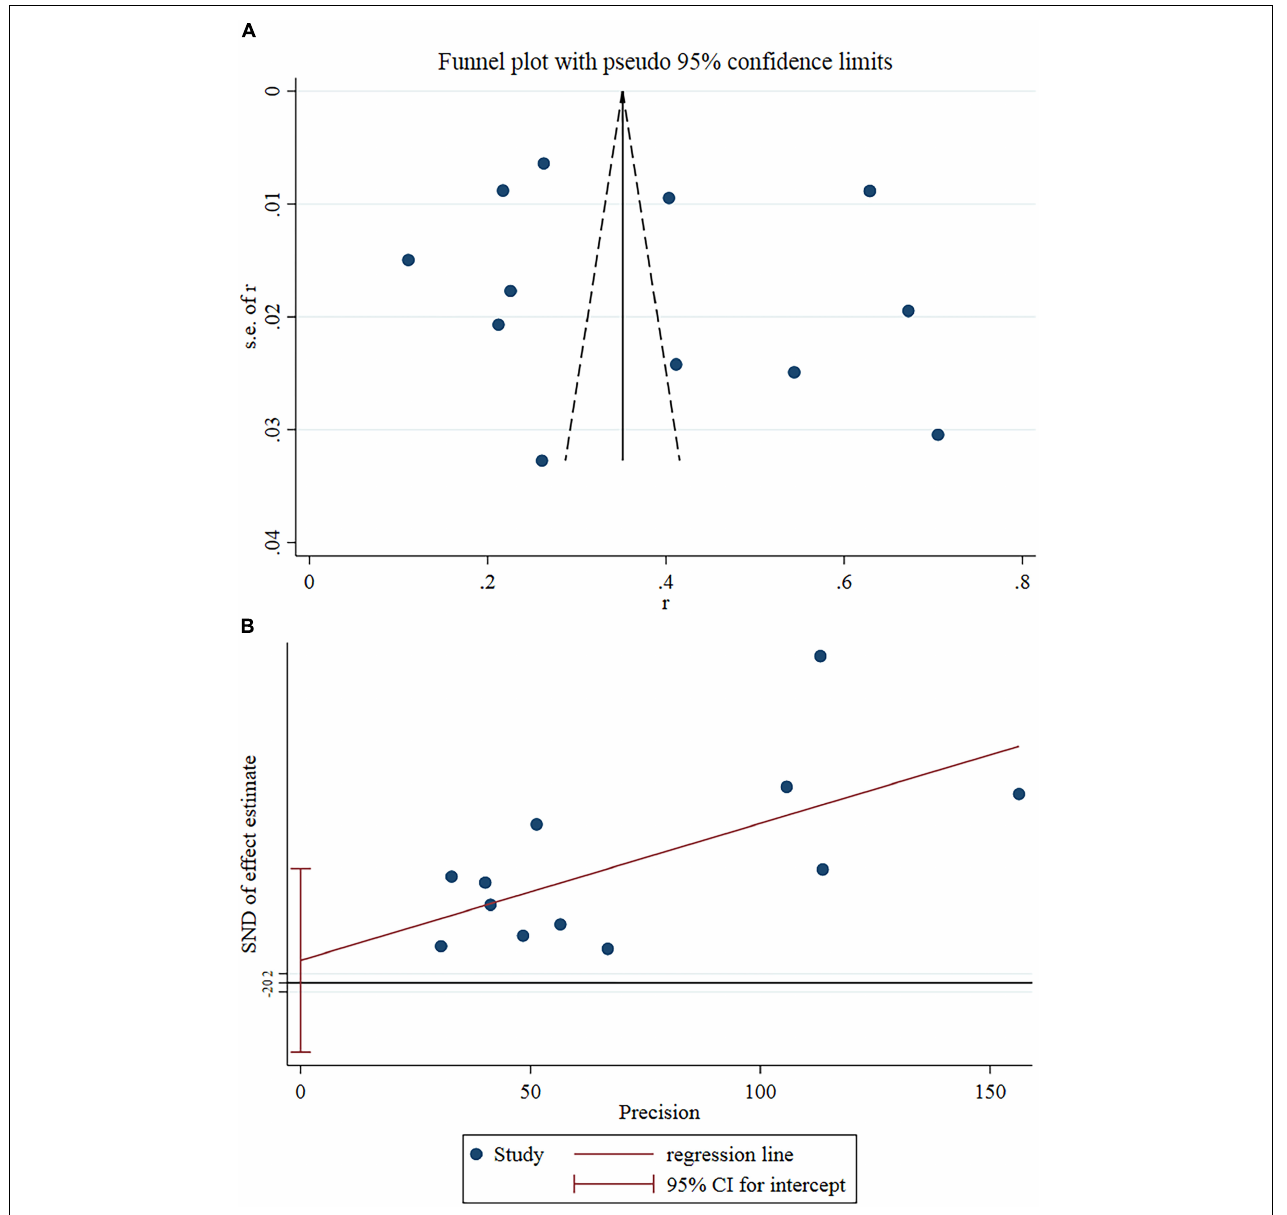
FIGURE 4 | (A) Funnel plots of eligible studies showed slight asymmetry. (B) Egger’s test showed no publication